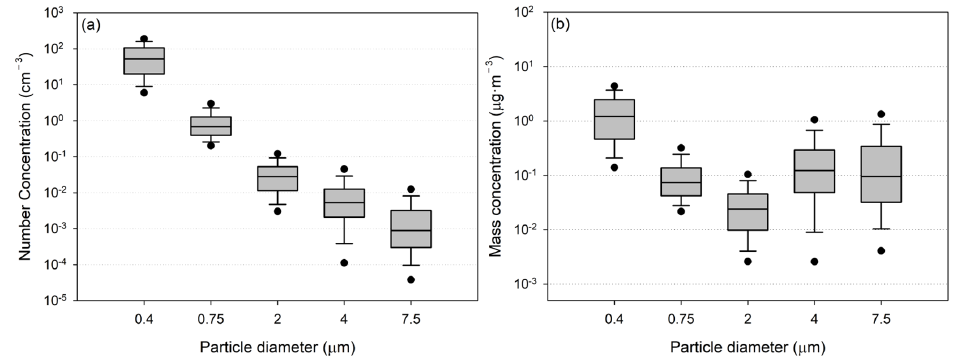
Figure 3. ( a ) Number and ( b ) mass concentration size distributions observed at each channel over the entire period. The bottom and top of each box represent the lower and upper quartiles, respectively, whereas the line within each box represents the median.